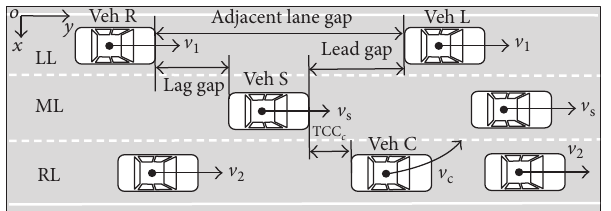
Figure 1: Driving scenario layout.